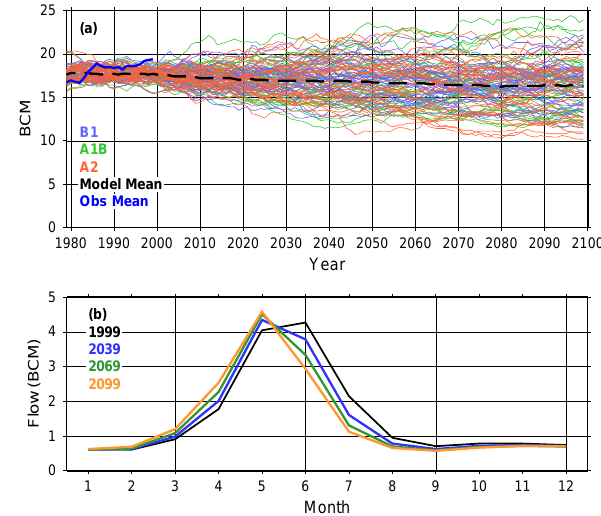
Fig. 6. (a) Simulated 30-yr average (trailing) streamflows of the Colorado River at Lees Ferry, AZ, 1979 through 2099. (b) The mean monthly average streamflows for the three future projection periods, compared with the historical 30-yr period flow ending in